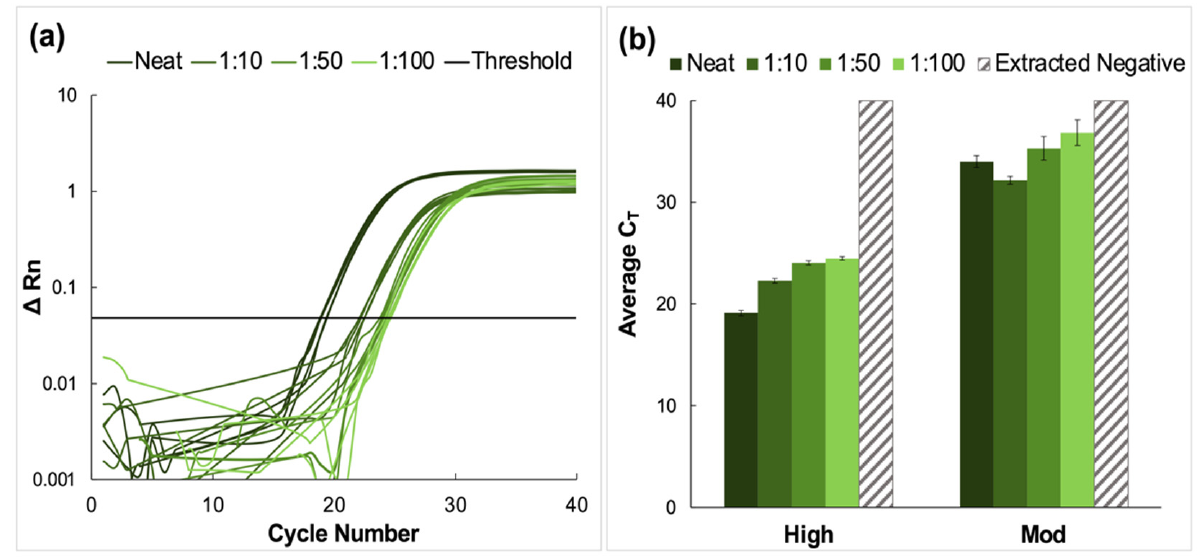
Figure 2. Amplification data obtained from pooling experiments using clinical nasopharyngeal swab samples. ( a ) A representative normalized amplification plot obtained from RT-PCR analysis of the extracted RNA (high viral titer). ( b ) Summary of CT data. Dilution ratios increase from left to right. Amplification was successful for all dilutions of high and moderate viral titer clinical samples ( n = 5). Tukey’s multiple comparisons tests showed that in the case of high viral titer clinical samples, there was no significant statistical difference between CT data obtained for the neat and 1:10 pools ( p > 0.9999). However, significant differences were obtained when the neat was compared to 1:50 and 1:100 dilutions ( p < 0.0001, in both cases), when the 1:10 pool was compared to 1:50 and 1:100 dilutions ( p < 0.0001, in both cases), and when the 1:50 and 1:100 pools were compared ( p = 0.0196). For moderate titer samples, there was no significant difference between the average CT values obtained for neat samples compared to those obtained for 1:10 and 1:50 dilutions ( p = 0.2040 and 0.0954, respectively). However, statistical differences were observed when the neat vs. 1:100, 1:10 vs. 1:50, 1:10 vs. 1:100, and 1:50 vs. 1:100 pools were compared ( p < 0.0001, 0.0016, <0.0001, and 0.0136, respectively).